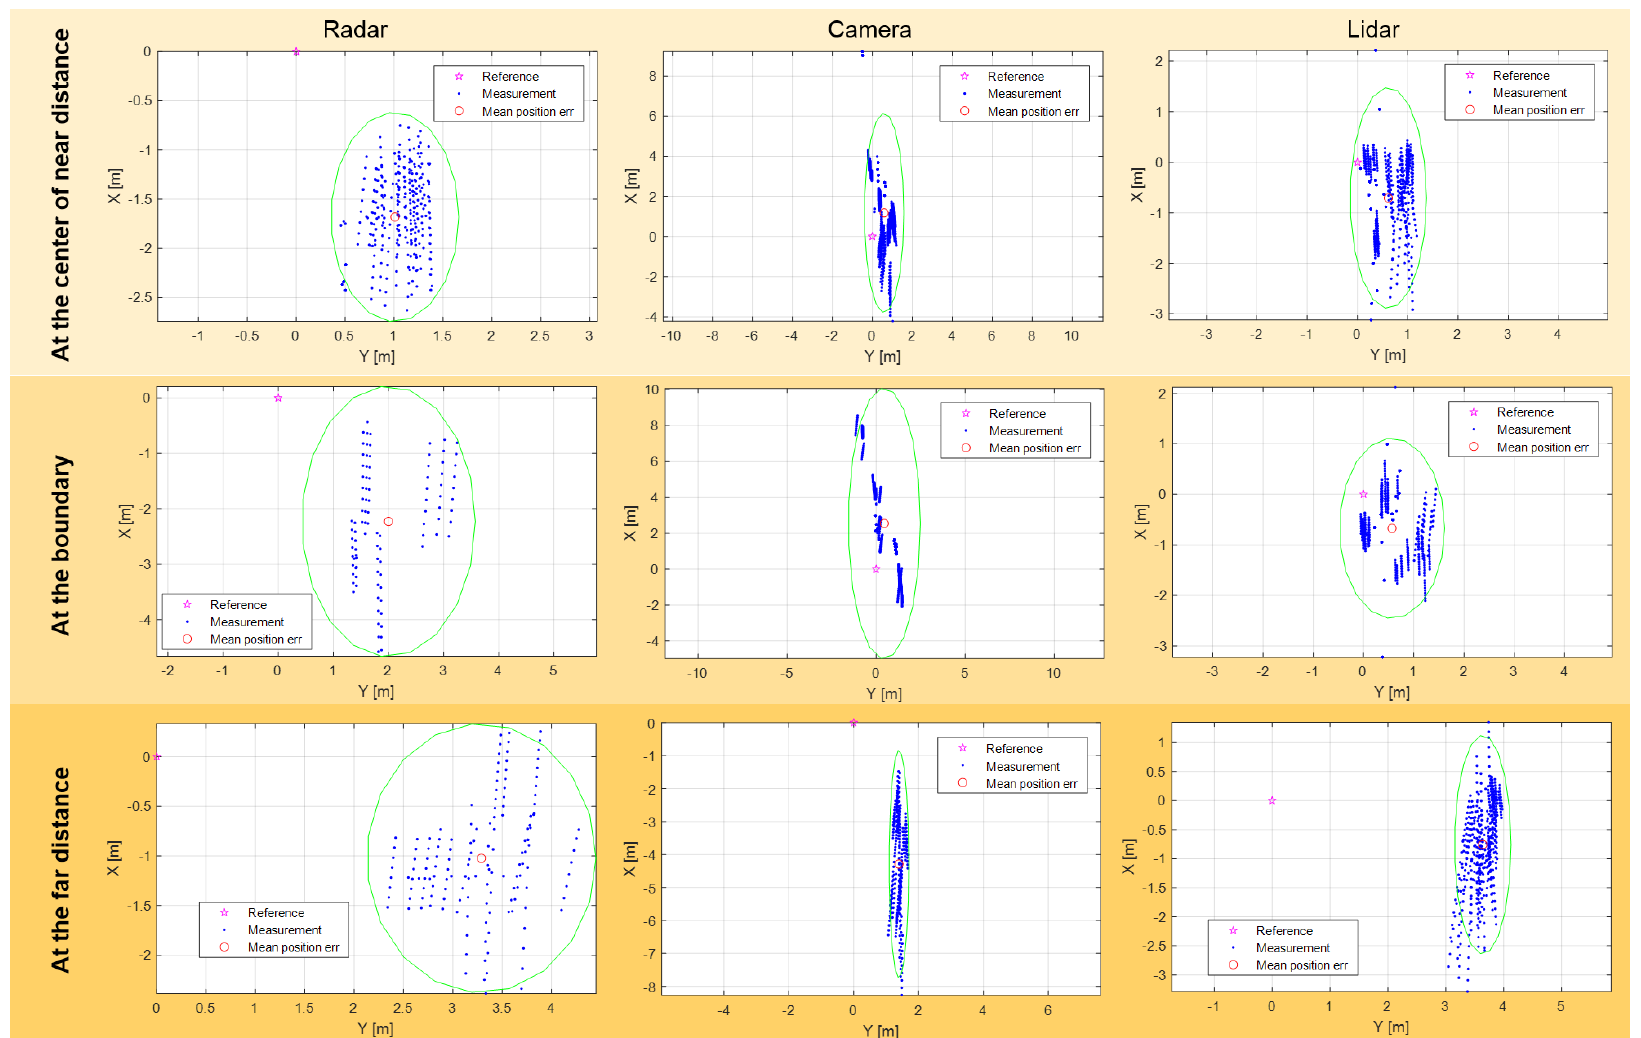
Figure A2. The mean position error and variance of the radar, camera, lidar at center of field of view, boundary, and far